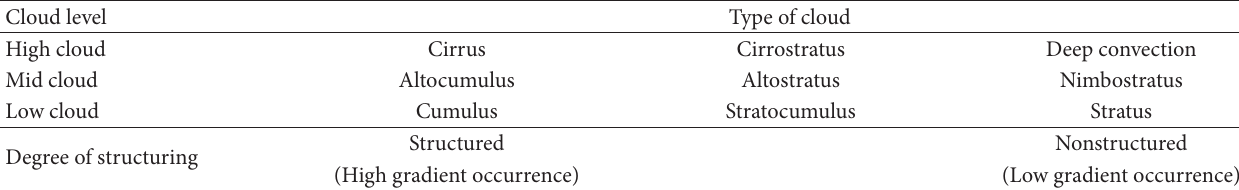
Table 1: Concept of cloud type classification using edge detection